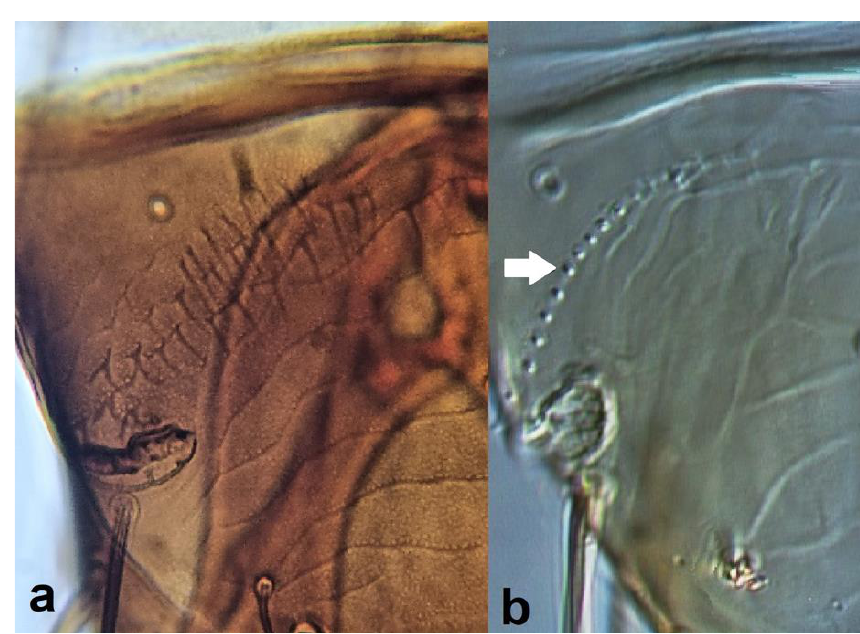
Figure 31. Left side of abdominal segment VII: ( a ) lacking ctenidia; ( b ) with ctenidia.